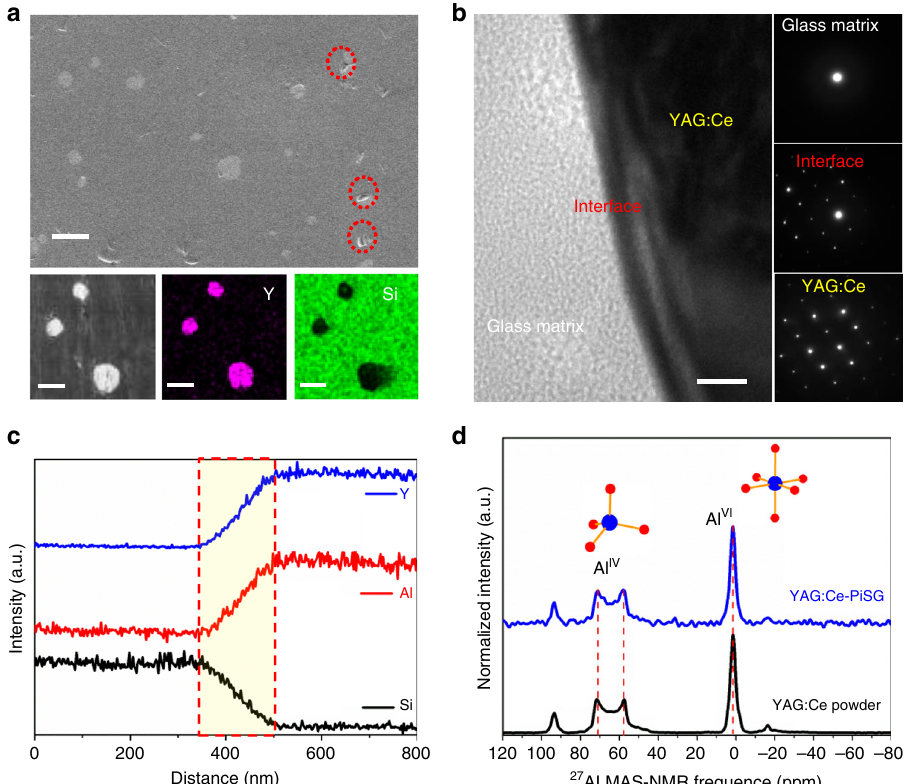
Fig. 3 Structural evidences for limited interfacial reaction between YAG:Ce and silica glass. a SEM (top) and EDS mapping (down) images of YAG:Ce- PiSG (scale bar, 25 μ m). Red circles denote the possible existence of pores. b TEM bright- fi eld image (left) and SAED patterns (right) of YAG:Ce-PiSG (scale bar, 50 nm). c TEM-EDS line scanning of YAG:Ce-PiSG. d Solid-state single-pulse 27 Al MAS-NMR spectra of YAG:Ce powder and 5 wt% YAG:Ce- PiSG. Asterisk (*) represents spinning sidebands and pound sign (#) satellite